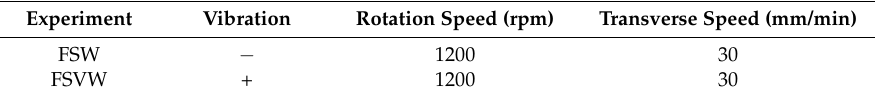
Table 1. Welding conditions for applied